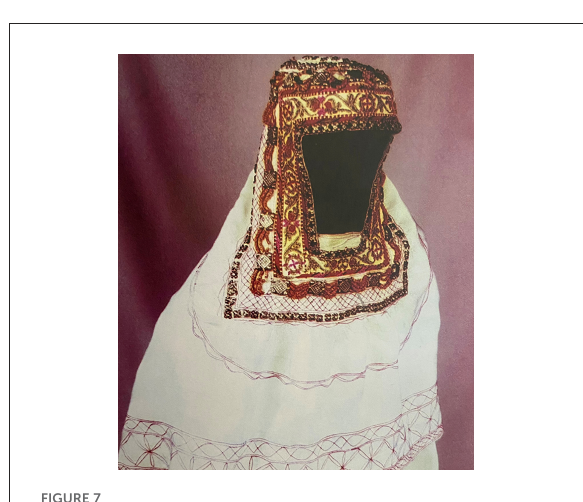
FIGURE7 Combined-type Headdress of the